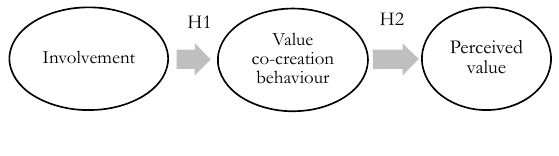
Fig. 1 – Research model Source: own